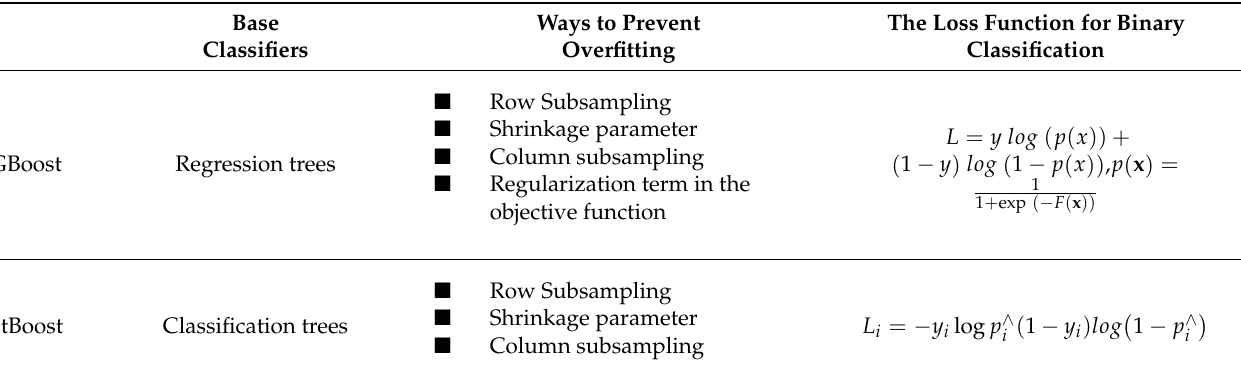
Table 2. XGBoost and CatBoost